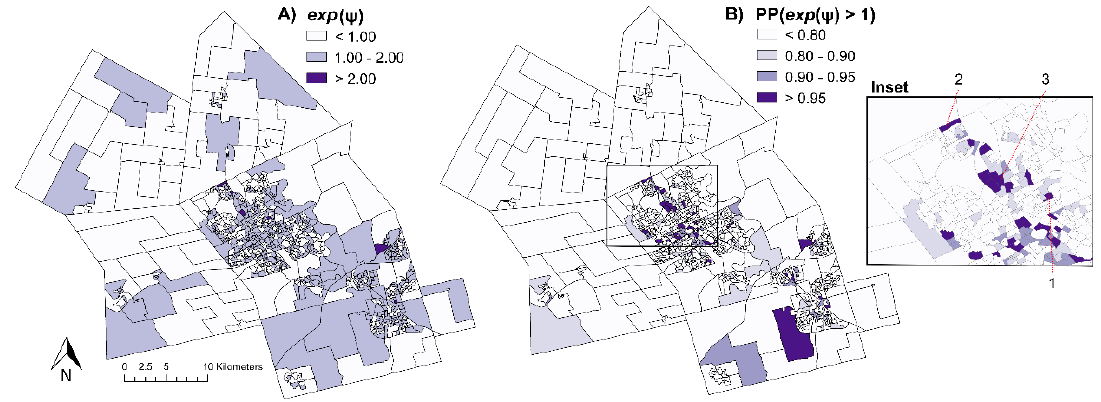
Figure 7. For 20:00–21:59, ( A ) space-time interaction and ( B ) space-time hotspots.